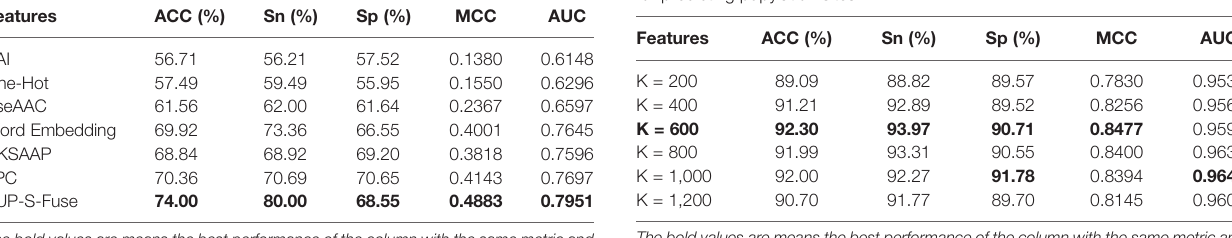
TABLE 6 | The effect of feature fusion Pup-S-Fuse by using the chi-square test for predicting pupylation sites.